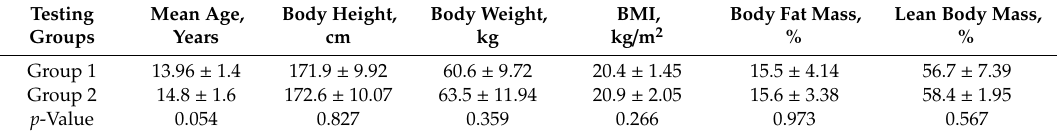
Table 1. Comparison of age, body weight (kg), body height (cm), body mass index (BMI), body fat mass percentage, and lean body mass percentage (mean value ± SD) in groups 1 and 2.